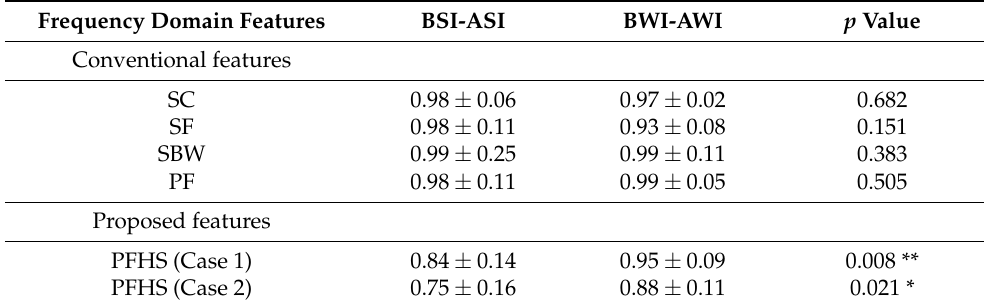
Table 1. Characteristics of the frequency domain features of BSs. Frequency Domain Features BSI-ASI BWI-AWI p Value Conventional